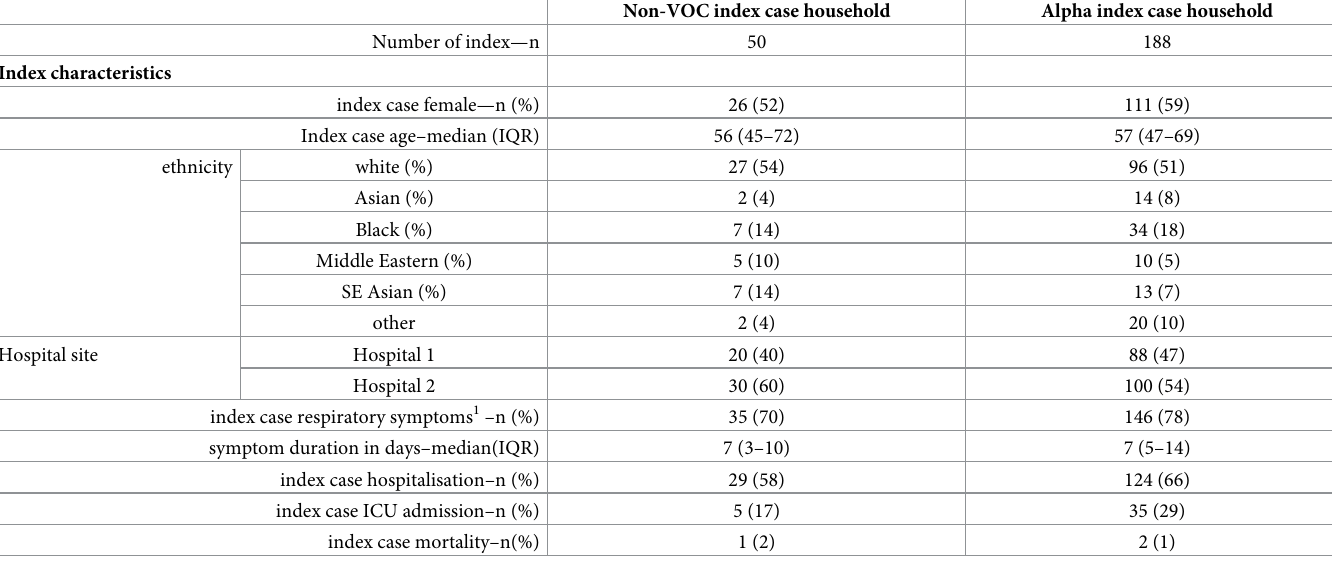
Table 1. Baseline characteristics of 238 index cases stratified by index case Alpha or non-VOC SARS-CoV-2